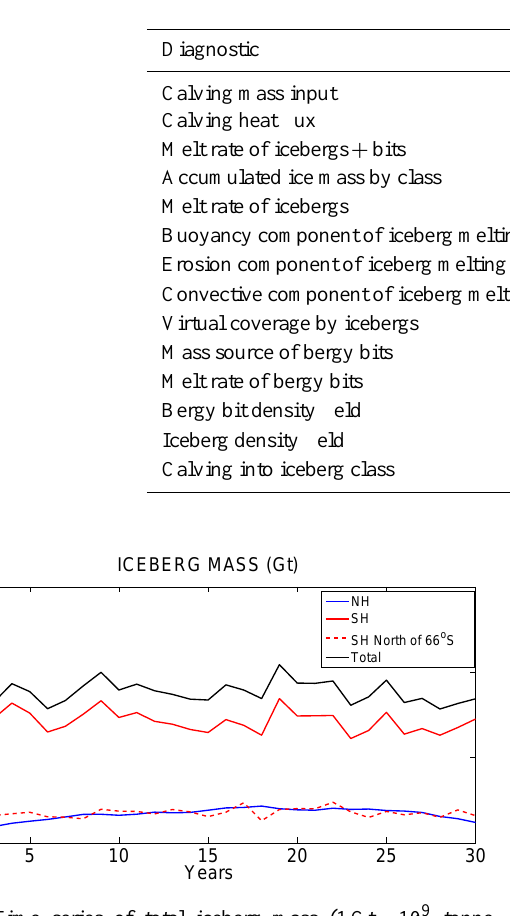
Table 1. Iceberg diagnostics saved in the standard NEMO tracer files.